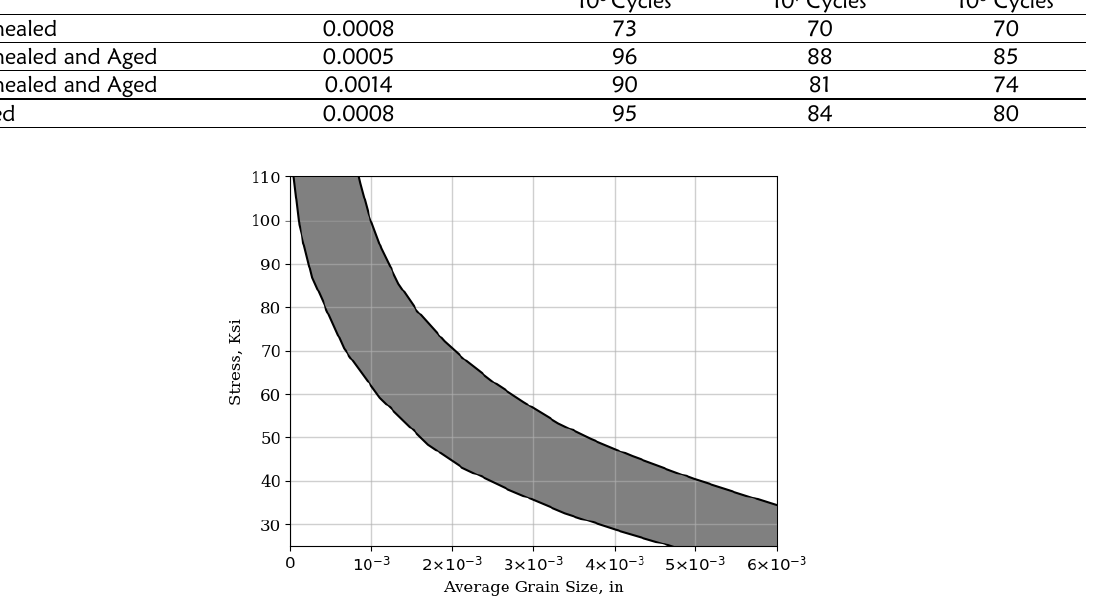
Figure 26: Effect of grain size on endurance limit of wrought IN718. Grain size variation due to differing heat treatment procedures